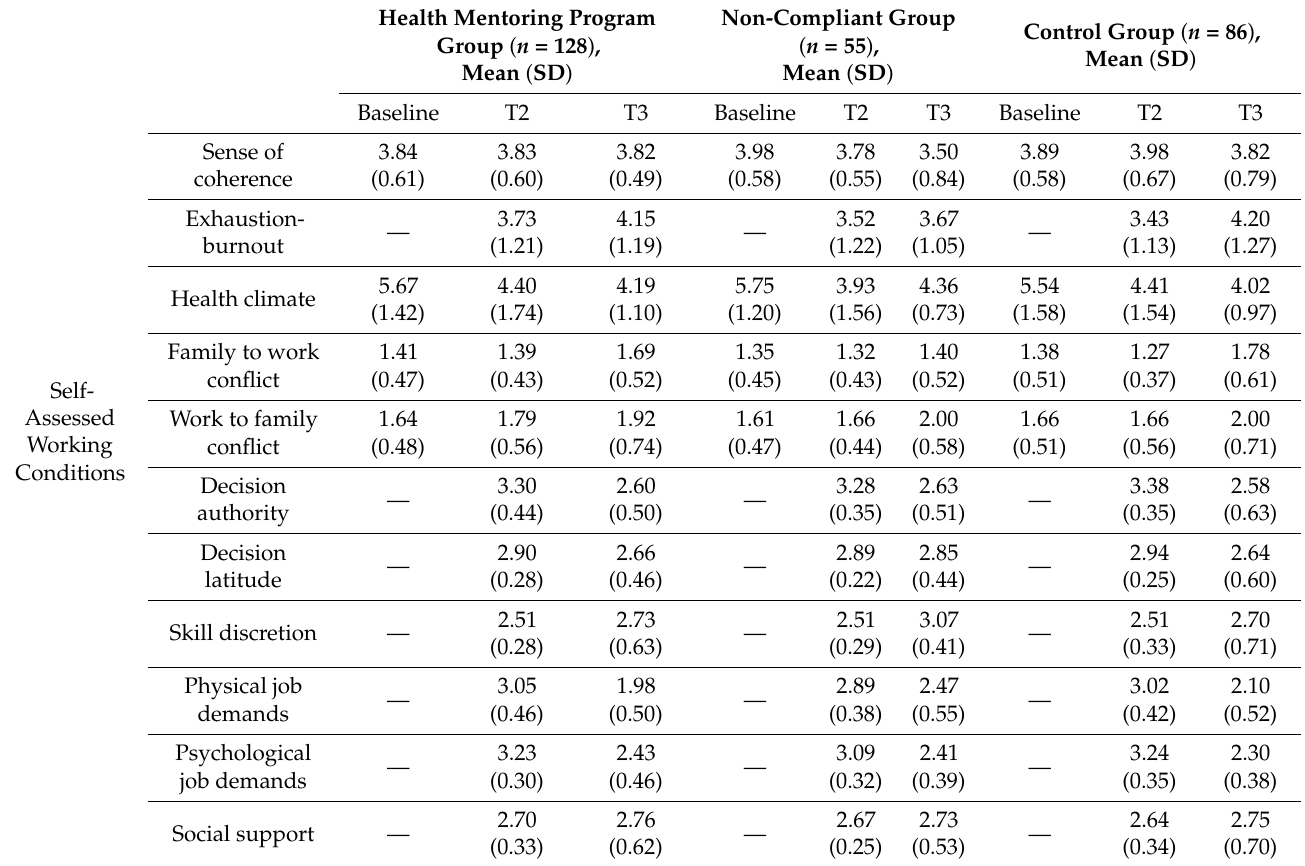
Table 3. Comparison of self-assessed working conditions among study groups in all 3 time